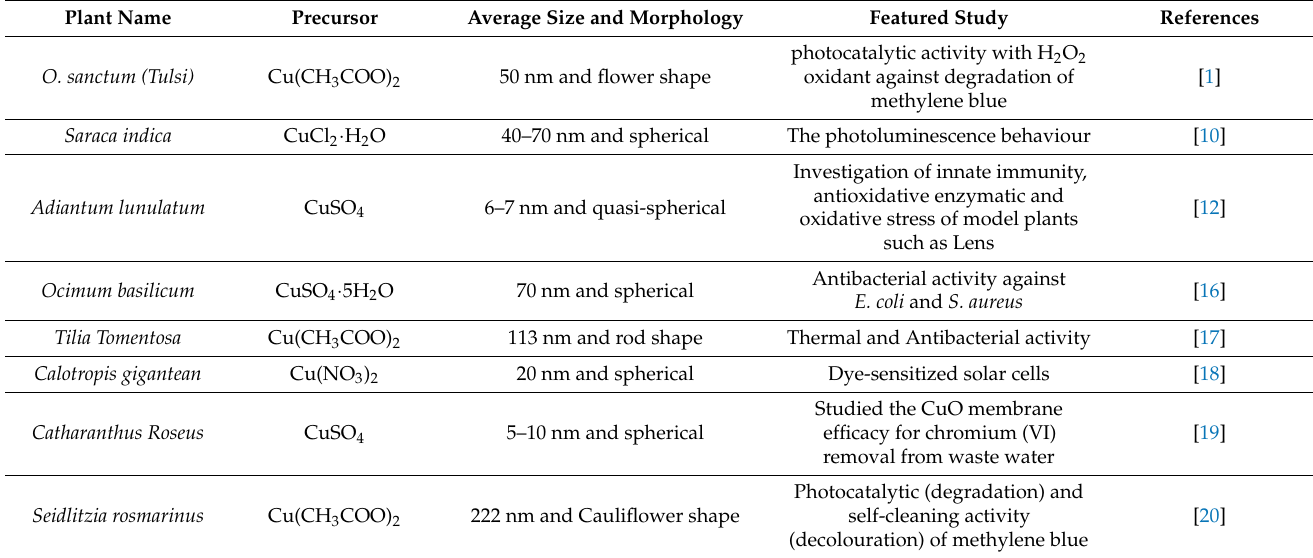
Table 1. Various researchers reported the synthesis of CuO nanoparticles using different